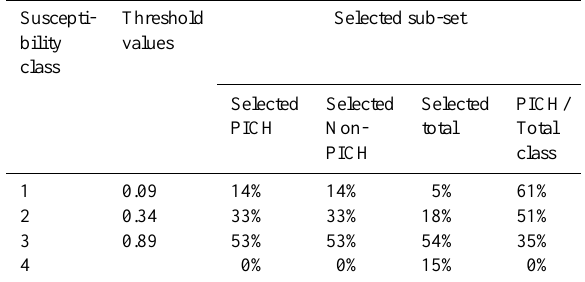
Table 7. Validation of the susceptibility rating